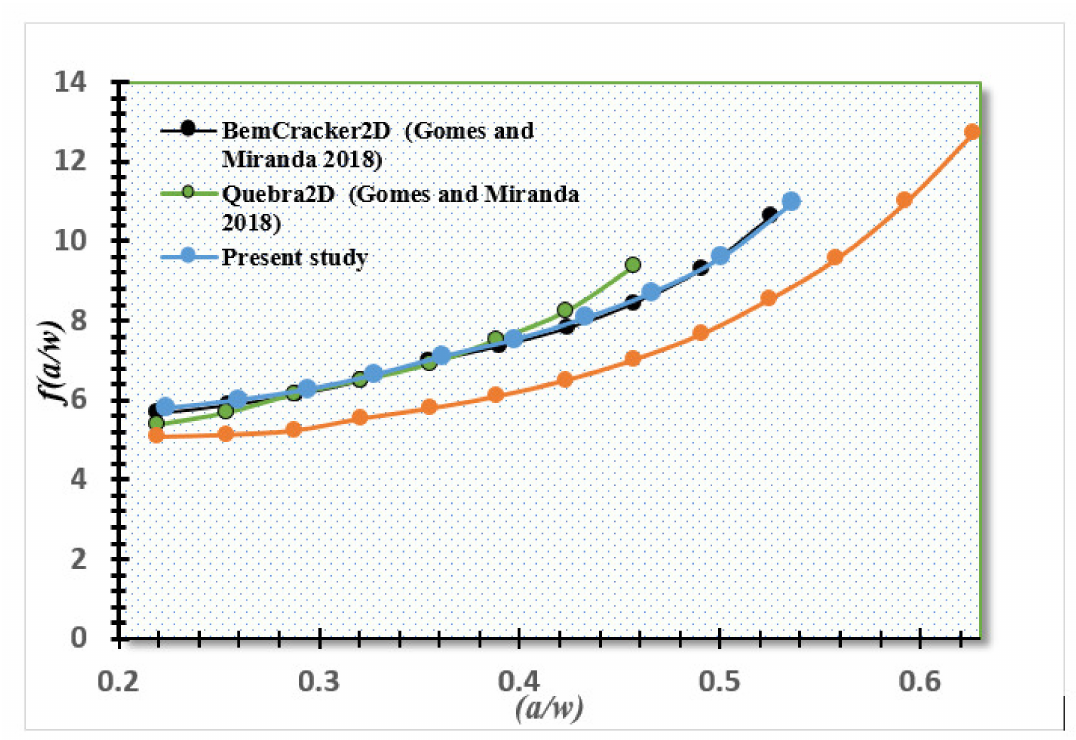
Figure 14. Dimensionless SIFs of the modified compact tension specimen CTS04 compared to the analytical solution and the work of